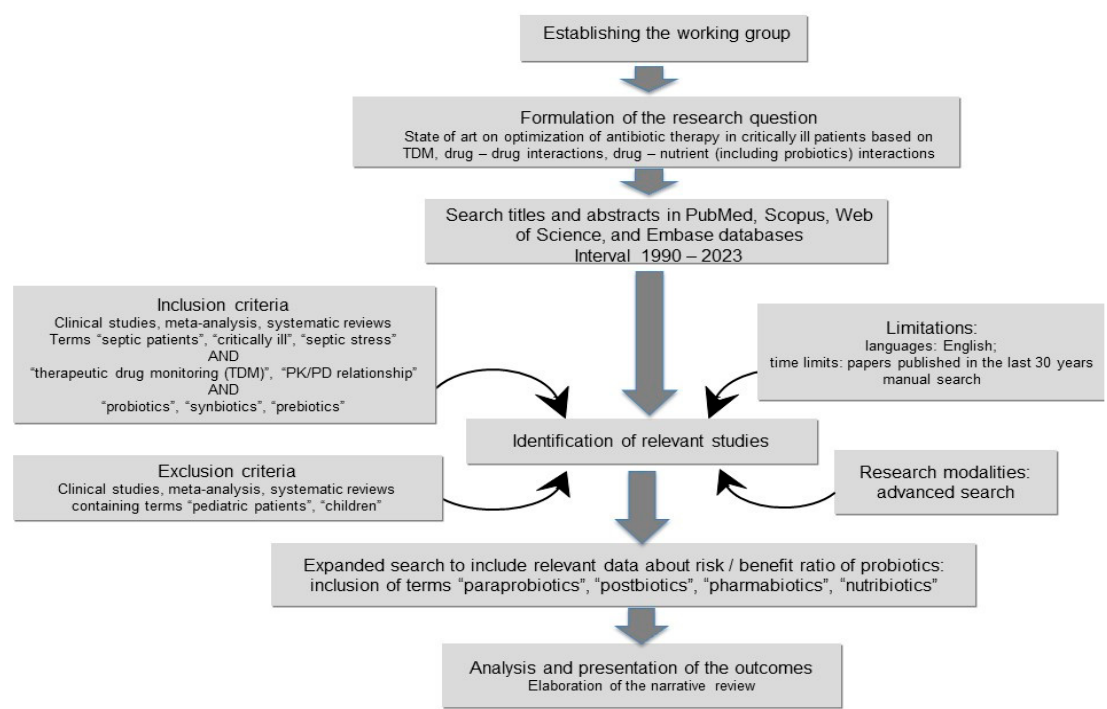
Figure 1. Flow chart of the literature search.